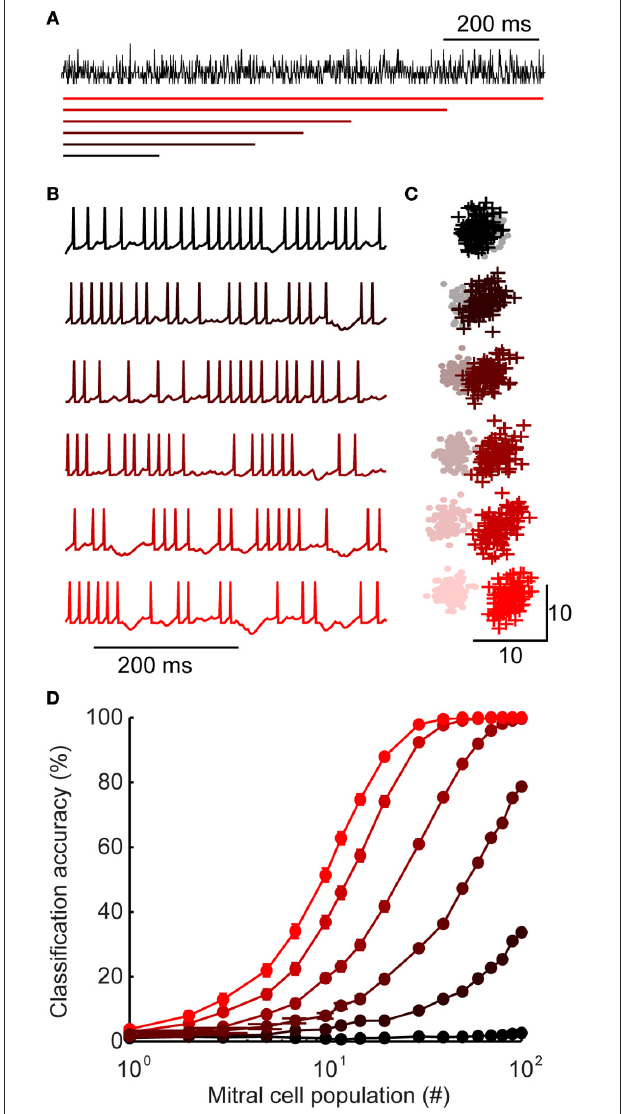
FIGURE 5 | Inhibition with widely distributed latency improves stimulus discrimination. (A) Generating inhibition. For each stimulus, a population spiking template is generated (shown here in black). Model granule cell spike times are assigned such that the sum of all spikes is equal to the peri-stimulus time histogram template. While the total spiking is equal across model variants, they differ in the range of first spike latencies (shown with colored bars, below). First spike latencies ranged between 0 and (from bottom to top) 200, 400, 500, 600, 800, or 1000ms. (B) Example of mitral cell spike trains receiving inhibition from each model variant shown in A . (C) First two principal components of mitral cell population firing for one pair of stimuli. Stimulus 1 = + ; stimulus 2 = • . For each model variant, 100 trials are plotted per stimulus. (D) Classification accuracy of 100 stimuli as a function of population size. Colors correspond to model variants plotted in A–C . Bars denote